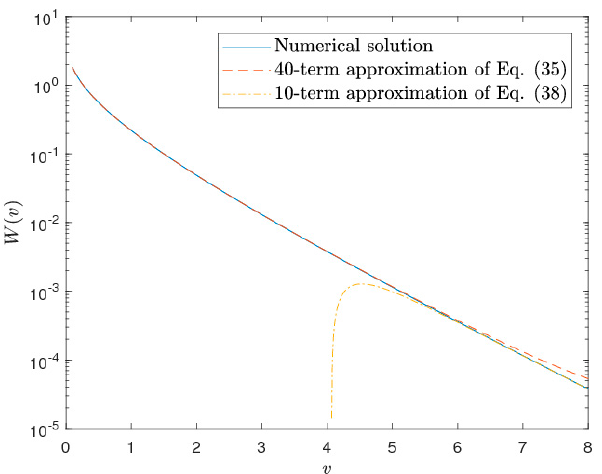
Figure 3. Comparison between numerical solution and 2, 5, and 100 terms of the series Equation (38) for 𝑊(𝑣) .